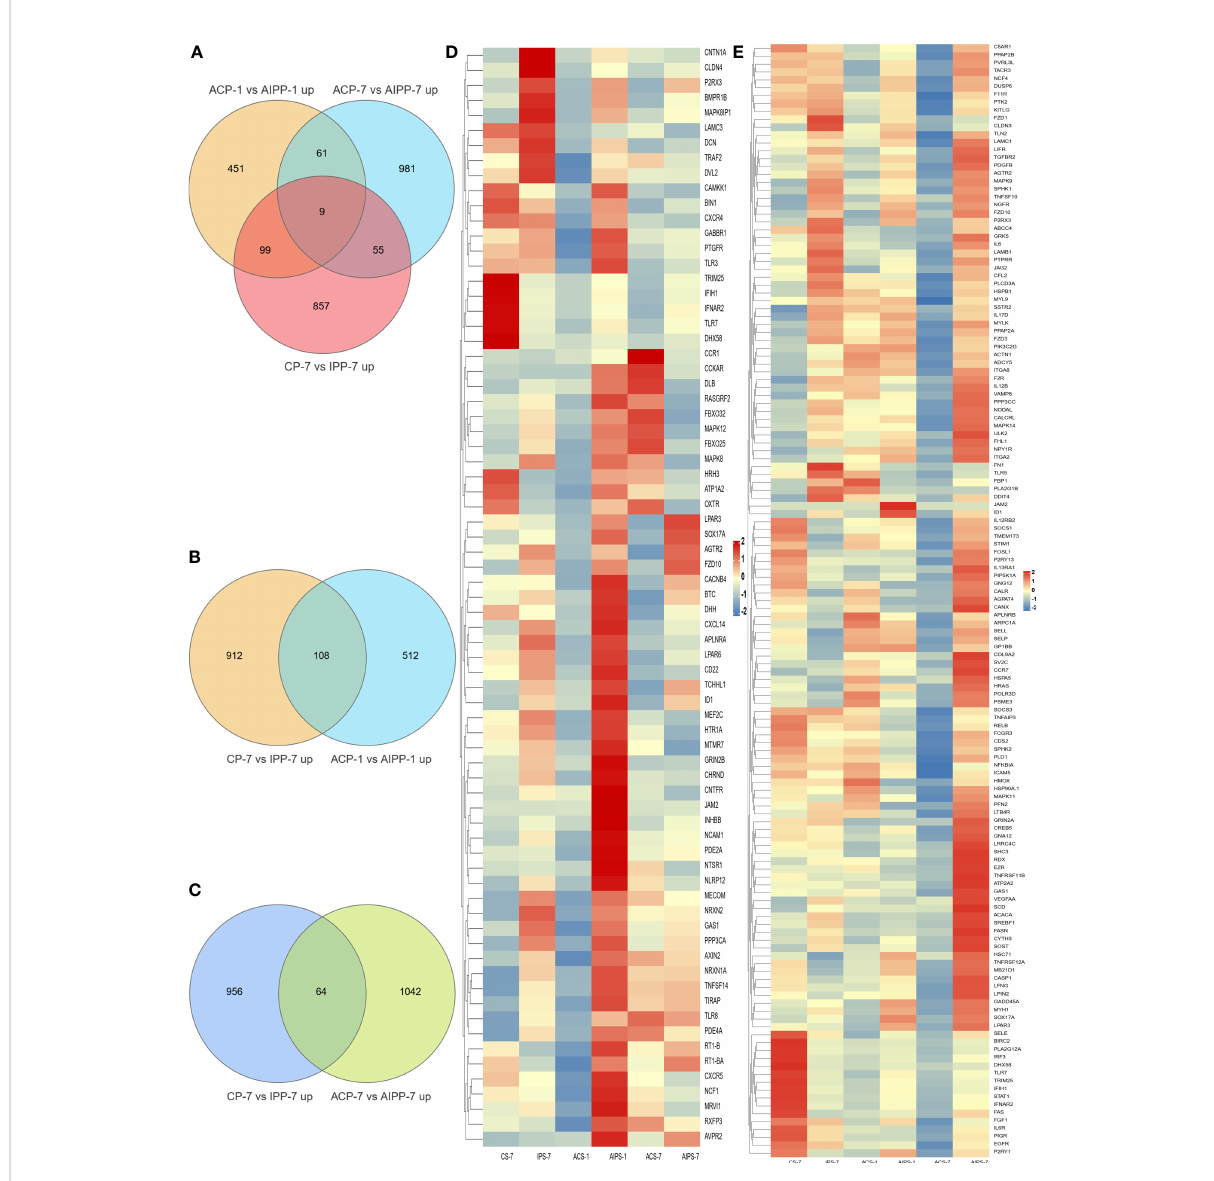
FIGURE 8 Venn diagram of upregulated genes between the PBS and inactivated vaccine groups at the three time points (A) . Venn diagram of genes upregulated between the seventh day after immunization and the fi rst day after challenge (B) and heat map of 73 immune-related genes speci fi cally upregulated on the fi rst day after challenge between the PBS and inactivated vaccine groups at the three time points (D) . Venn diagram of genes upregulated between day 7 after immunization and day 7 after challenge (C) and heat map of 141 immune-associated genes speci fi cally upregulated on day 7 after challenge in the PBS and inactivated vaccine groups at three time points (E) . The color shades in the heat map represent the gene expression levels. Closer to red indicates greater expression and closer to blue less